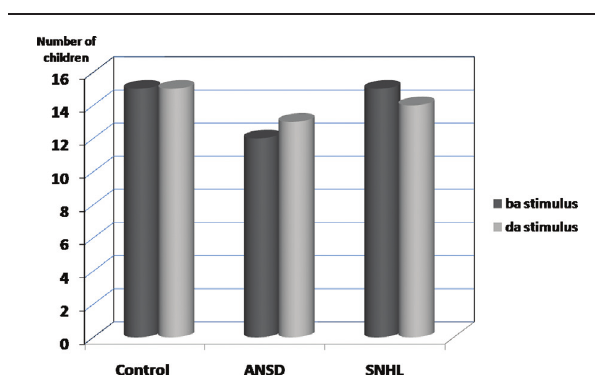
The percent of children in the three groups with recordable P1 cortical auditory evoked potentials